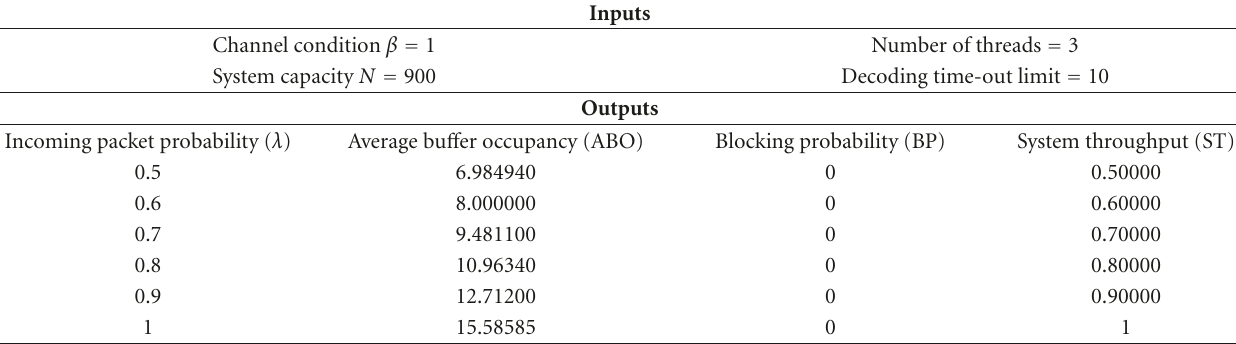
Table 1: ABO, blocking probability, and system throughput ( β = 1 . 0, T = 10).